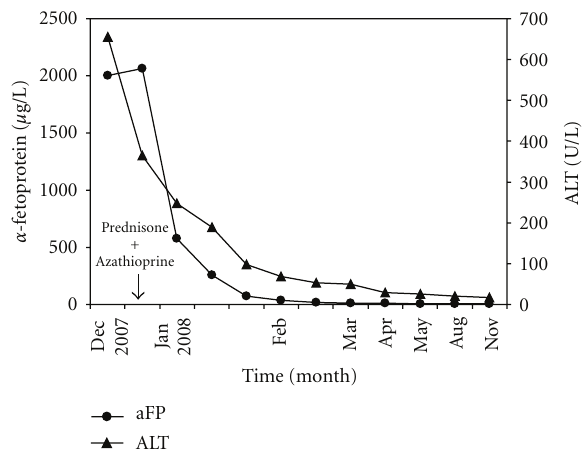
Figure 1: Serum alpha-fetoprotein (aFP) and alanine aminotrans- ferase (ALT) concentrations in an 18-year-old male patient with autoimmune hepatitis. Both markers normalized in several months after treatment with Prednisone and Azathioprine was started.